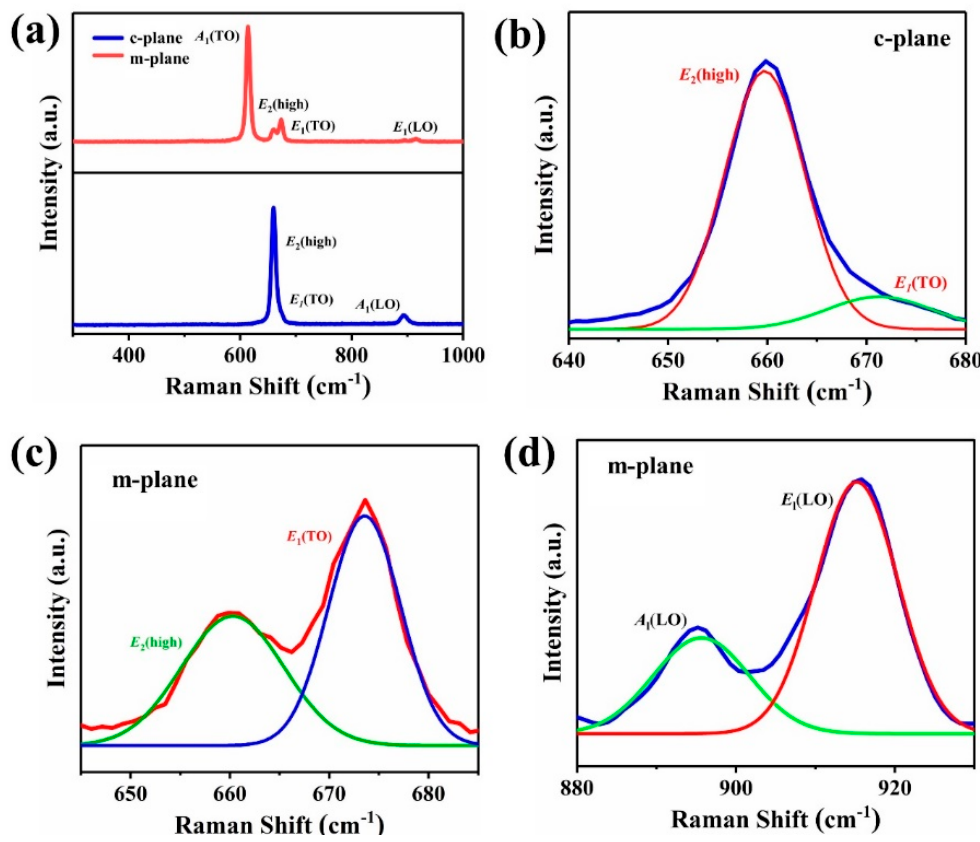
Figure 5. Raman spectrum of the samples ( a ) and the fitting Raman peaks of the c-plane ( b ) and m-plane ( c , d ).